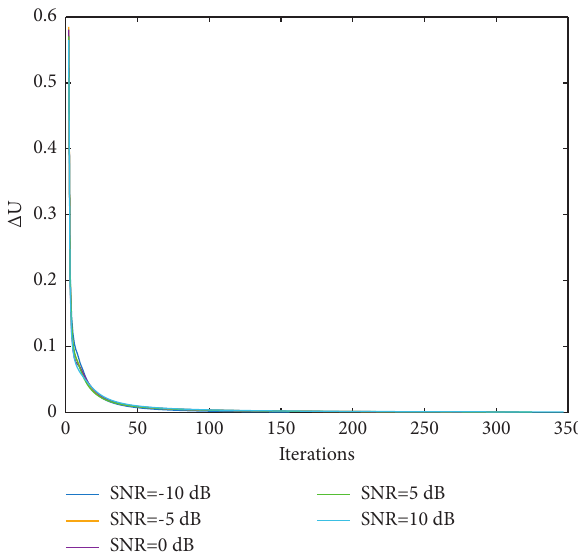
Figure 2: Convergence of the proposed method.